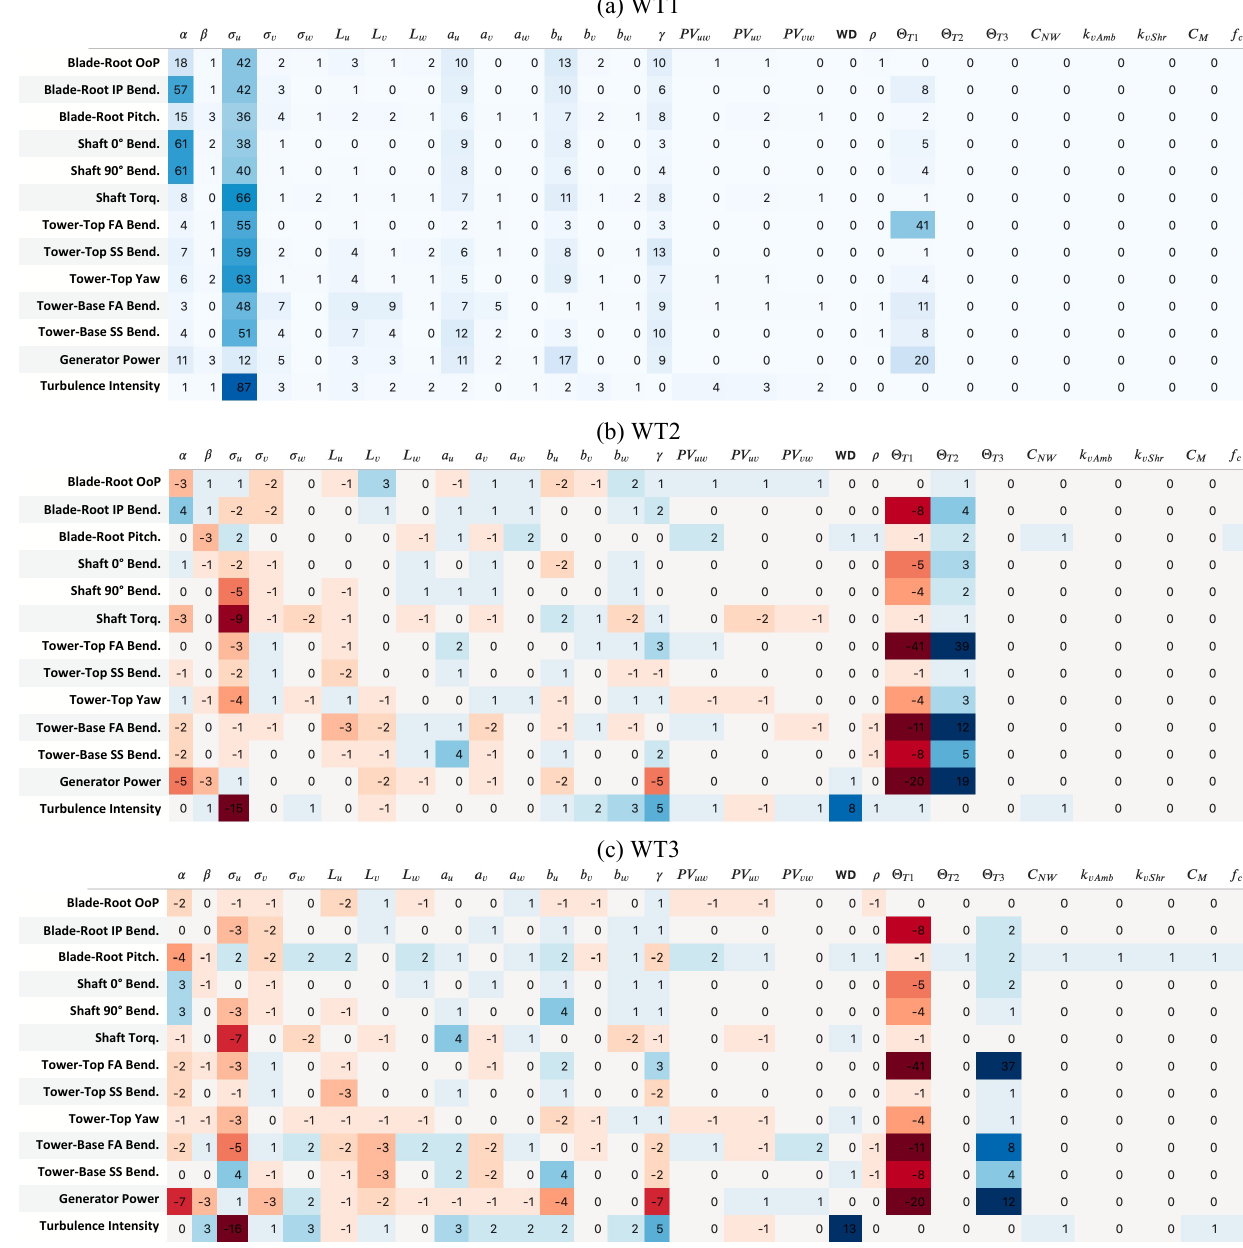
Table 7. Tabulated results for the number of fatigue load significant events for each input parameter, separated by QoI. Cells are colored by the count value, with darker blue representing a more positive count and darker red representing a more negative count. Results for WT1 show the absolute number of significant events, while results for WT2 and WT3 show the number of significant events relative to